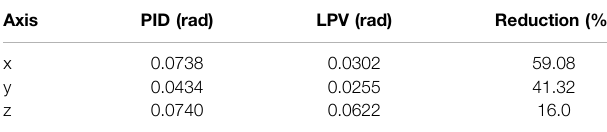
TABLE 2 | Quantitative analysis of the magnetic moment fl